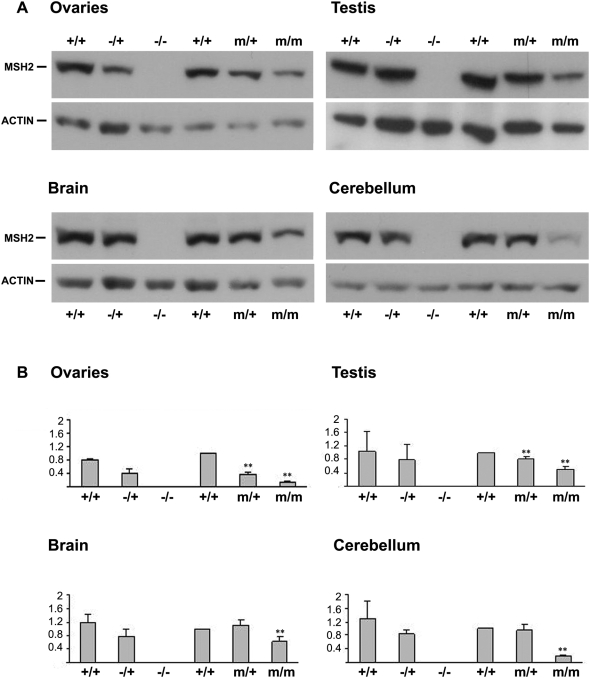
MSH2 protein levels in 3 to 4-month-old mice carrying different Msh2 genotypes.(A) Western blot analysis of MSH2 protein levels in ovaries, testis, brain and cerebellum from Msh2+/+, Msh2−/+, Msh2−/− (C57BL/6J, 129/OLA, FVB), Msh2+/+, Msh2m/+ and Msh2m/m (>90% C57BL/6J) mice. β-actin was used as a loading control. Each lane represents pooled protein extracts from three mice. MSH2: 104 kDa and β-actin: ±42kDa. (B) The graphs show the quantitative analysis of MSH2 protein expression levels relative to β-actin in the tested tissues. The quantification has been performed by western blotting reproduced at least three times for each tissue. The x-axis shows MSH2/β-actin ratio. For each graph, all values have been calculated considering the value of Msh2+/+ (C57BL/6J) as the reference value 1. **, p<0.005. +/+, m/+ and m/m represent genotypes at the murine locus for Msh2. +: wild-type allele; m, Msh2G674A mutation. Error bars correspond to S.D.